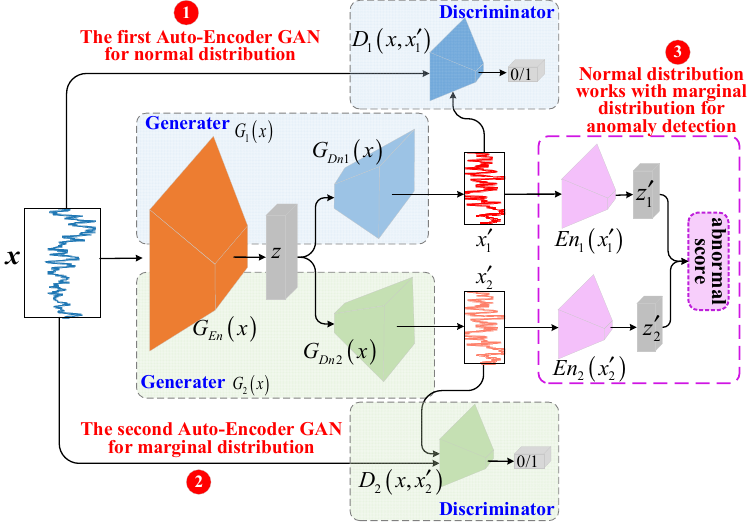
Figure 2. The pipeline of DAGAN